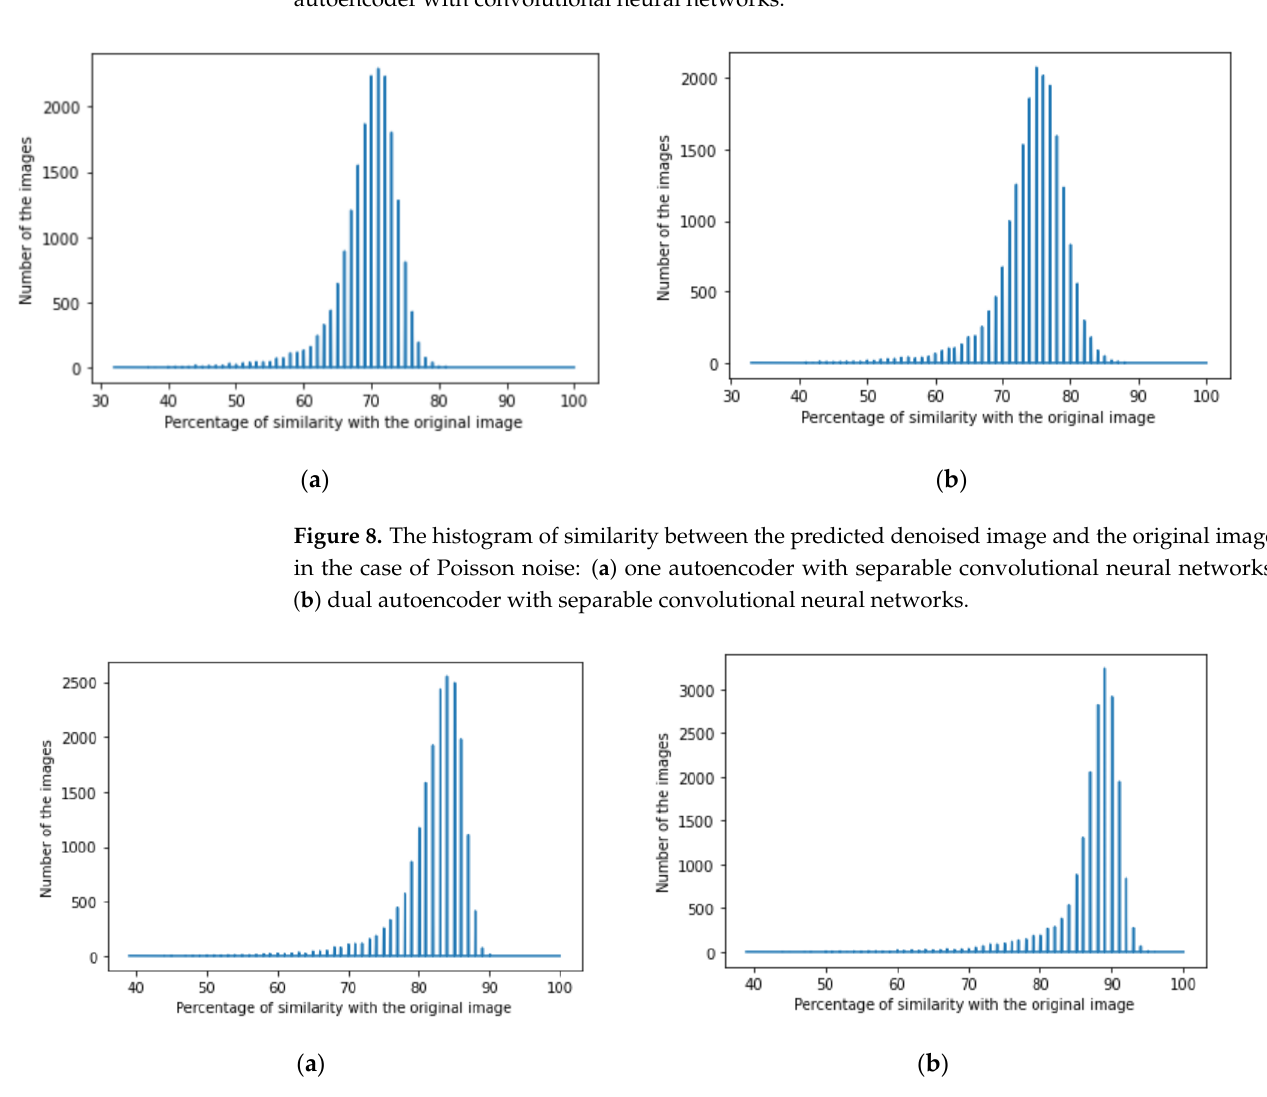
Figure 9. The histogram of similarity between the predicted denoised image and the original image in the case of speckle noise: ( a ) one autoencoder with convolutional neural networks; ( b ) dual autoencoder with convolutional neural networks.